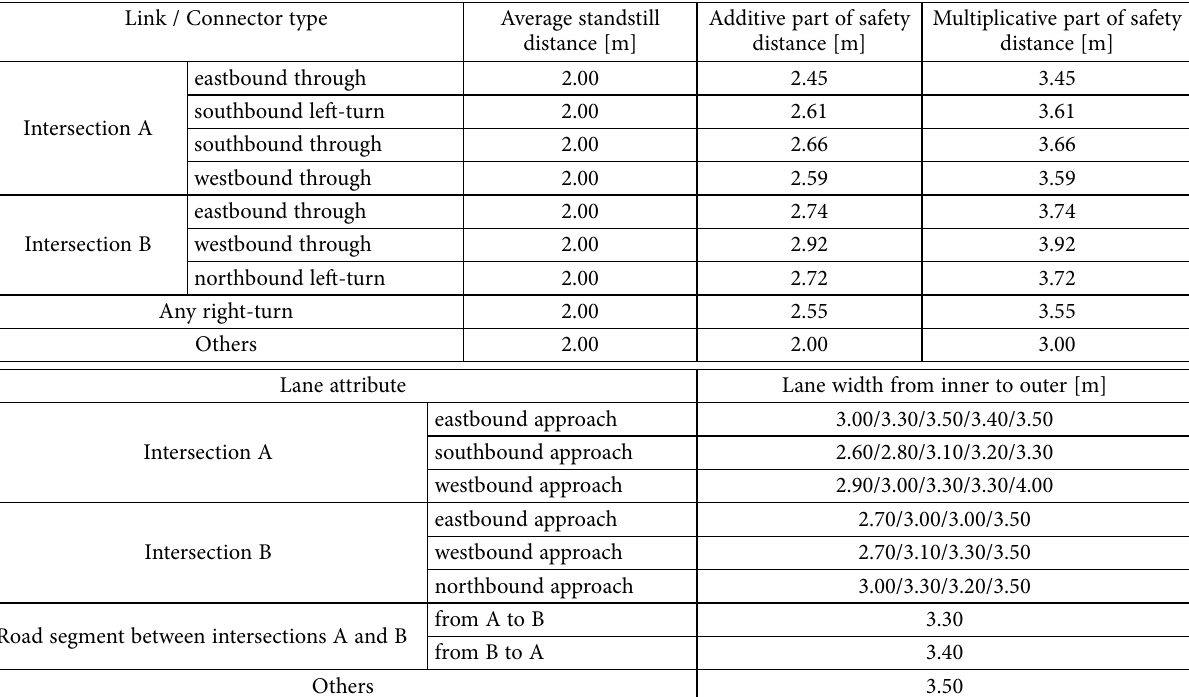
Table 6. Settings of driving behaviour parameters and lane